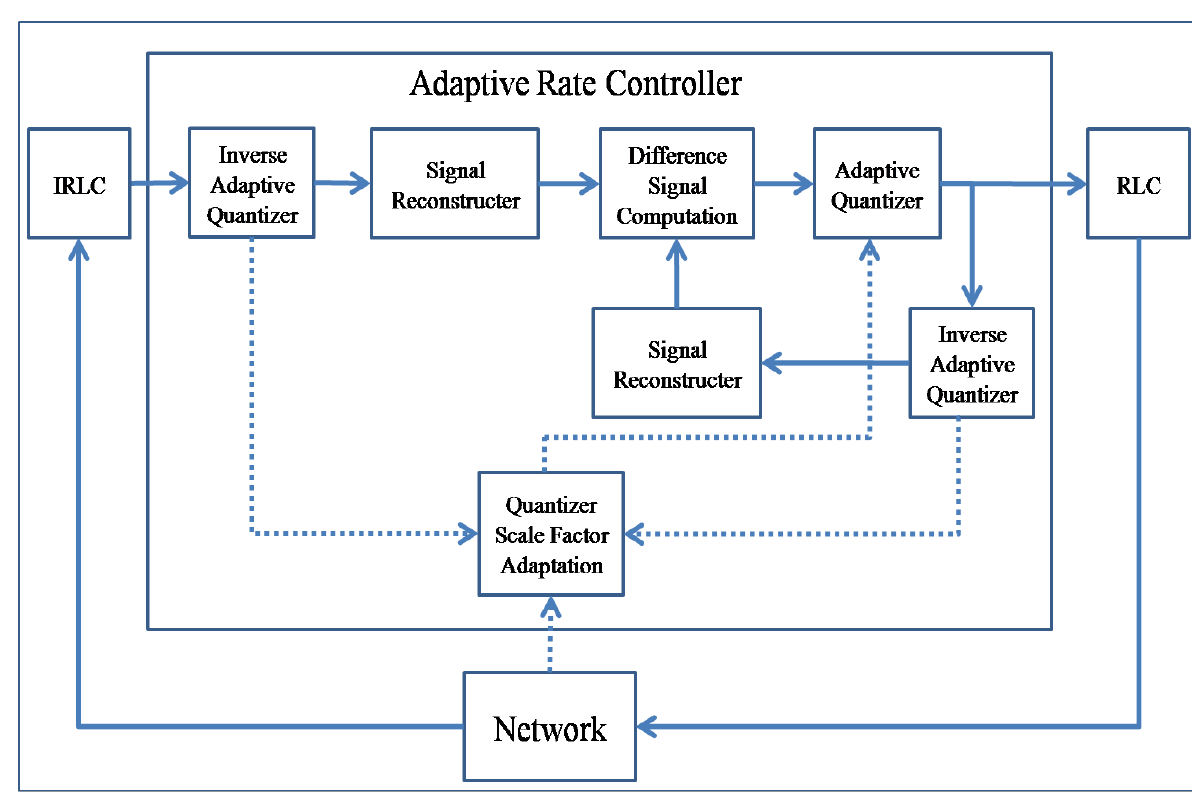
Figure 8. Block schematic of